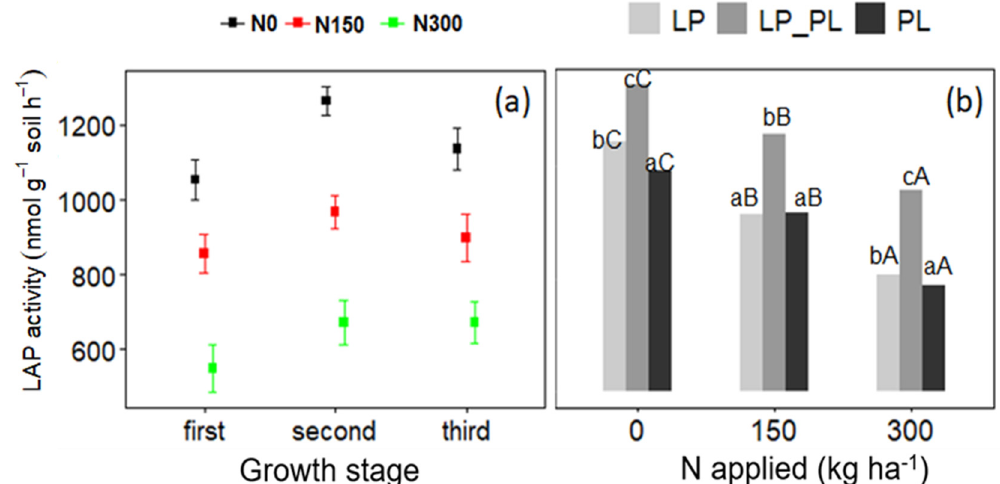
Figure 2. Graphs showing leucine aminopeptidase (LAP) expression in fertilized soils cultivated with forage species as affected by ( a ) the stage of growth and ( b ) sward type. Lowercase and uppercase letters represent significant differences between the sward types and the N rate, respectively. LP represents Lolium perenne; PL represents Plantago lanceolata.